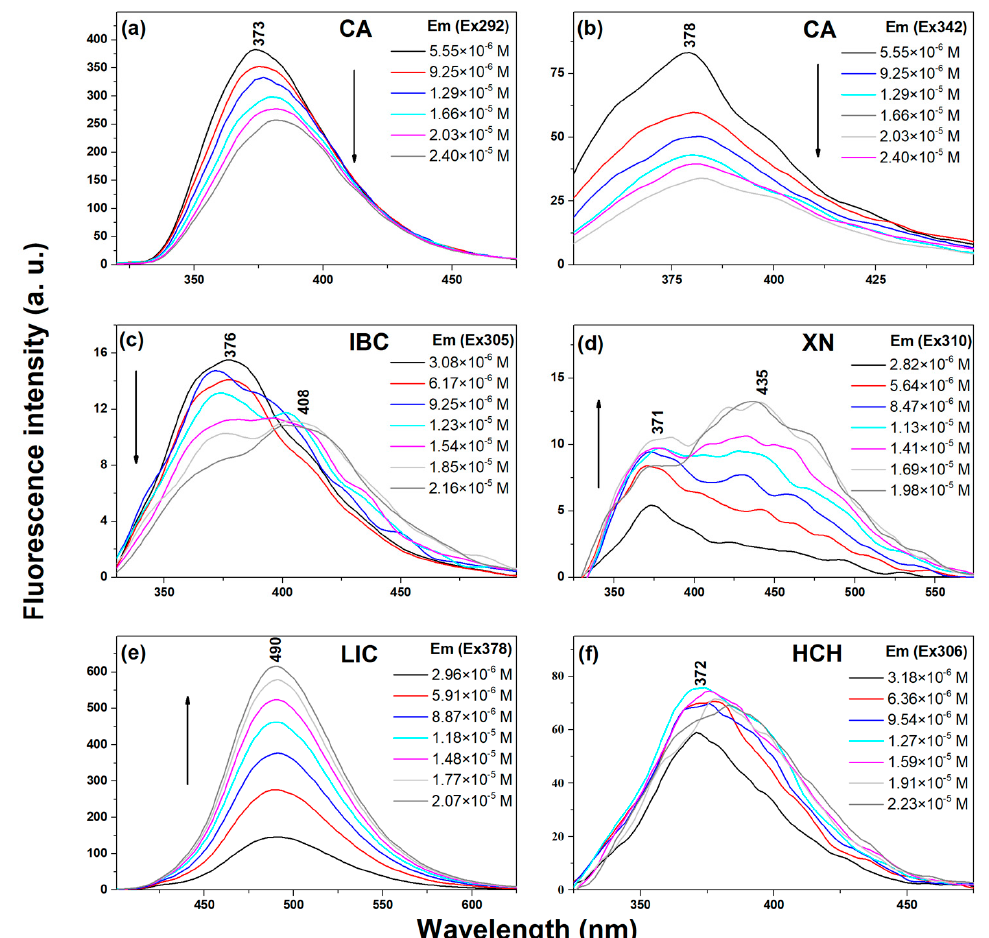
Figure 2. Fluorescence emission spectra of chalcones CA, IBC, XN, LIC and HCH in the methanol solution at different concentrations. The excitation was set at the fluorescence emission maximum of each sample, as pointed out in the figure. ( a ) CA Em (Ex 292), ( b ) CA Em (Ex 342), ( c ) IBC Em (Ex 305), ( d ) XN Em (Ex 310), ( e ) LIC Em (Ex 378) and ( f ) HCH Em (Ex 306).